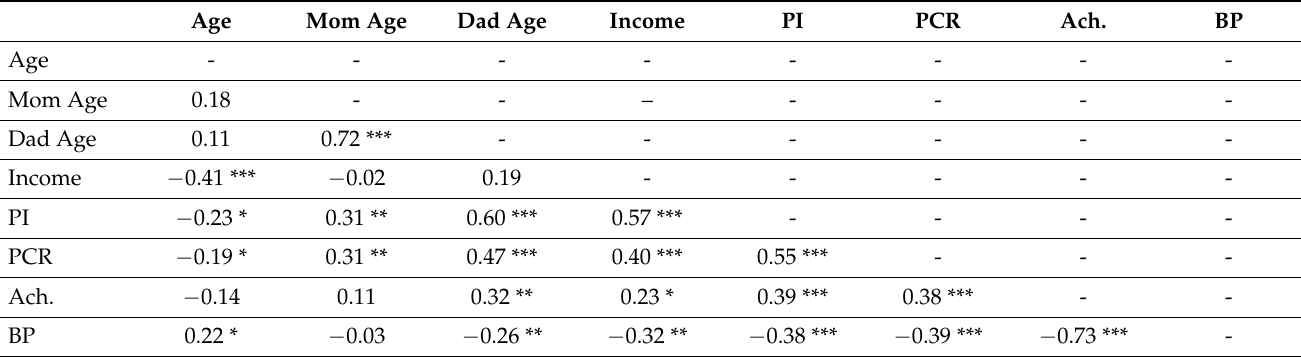
Table 9. Correlations for demographic variables.